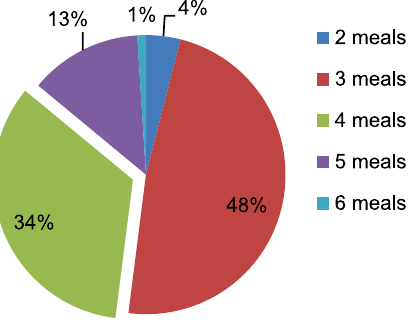
FIGURE 2. number of daily meals